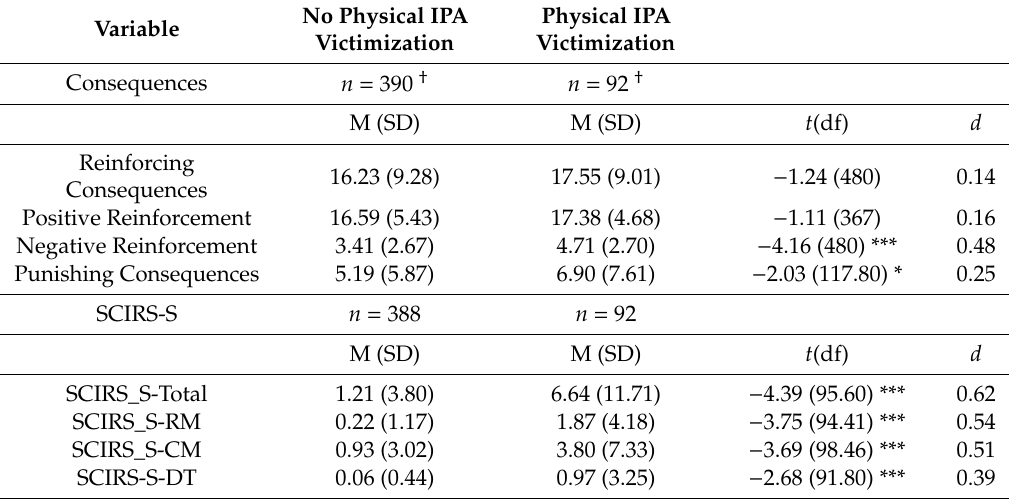
Di ff erences in Sexting Consequences and Sexual Coercion Based on Physical IPA Victimization